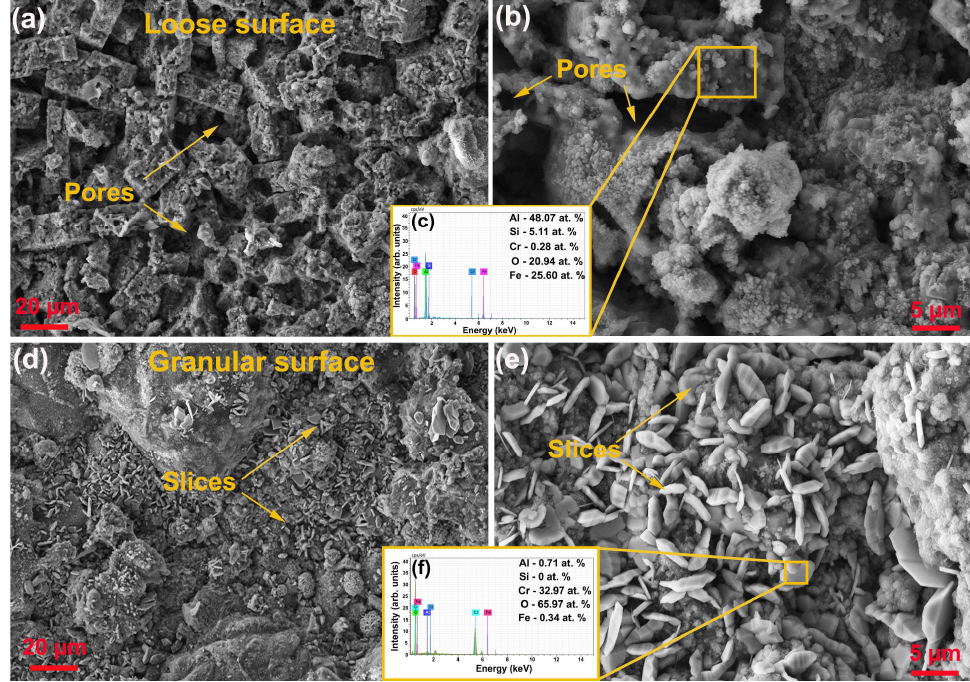
Figure 5. Surface SEM images with the corresponding EDS spectra of all samples after 200 h hot-salt corrosion tests: ( a – c ) M1; ( d – f ) M2.